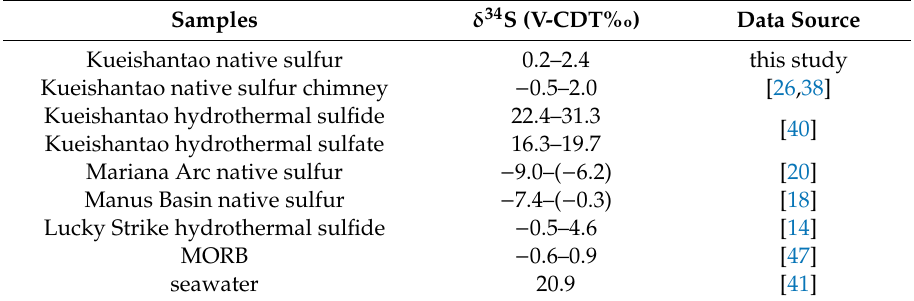
Table 3. Comparison of sulfur isotopic values for Kueishantao native sulfur with published